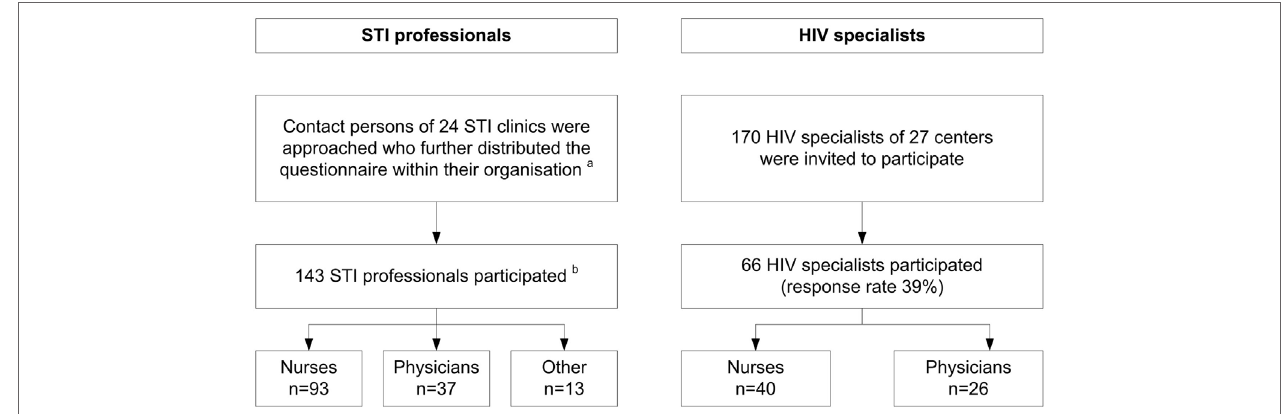
FigUre 1 | Flowchart of recruitment procedures of STI professionals working at STI clinics of the Public Health Service and HIV specialists working at HIV treatment centers, the Netherlands, 2015. (a) Total number of persons invited by contact persons is unknown. (b) Response rate was 54% (104/191) among nine clinics that provided data on the number of questionnaires distributed. STI, sexually transmitted